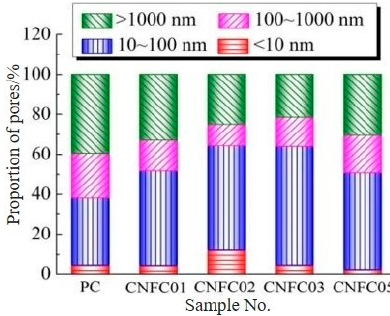
Figure 15. Proportion of various pores.